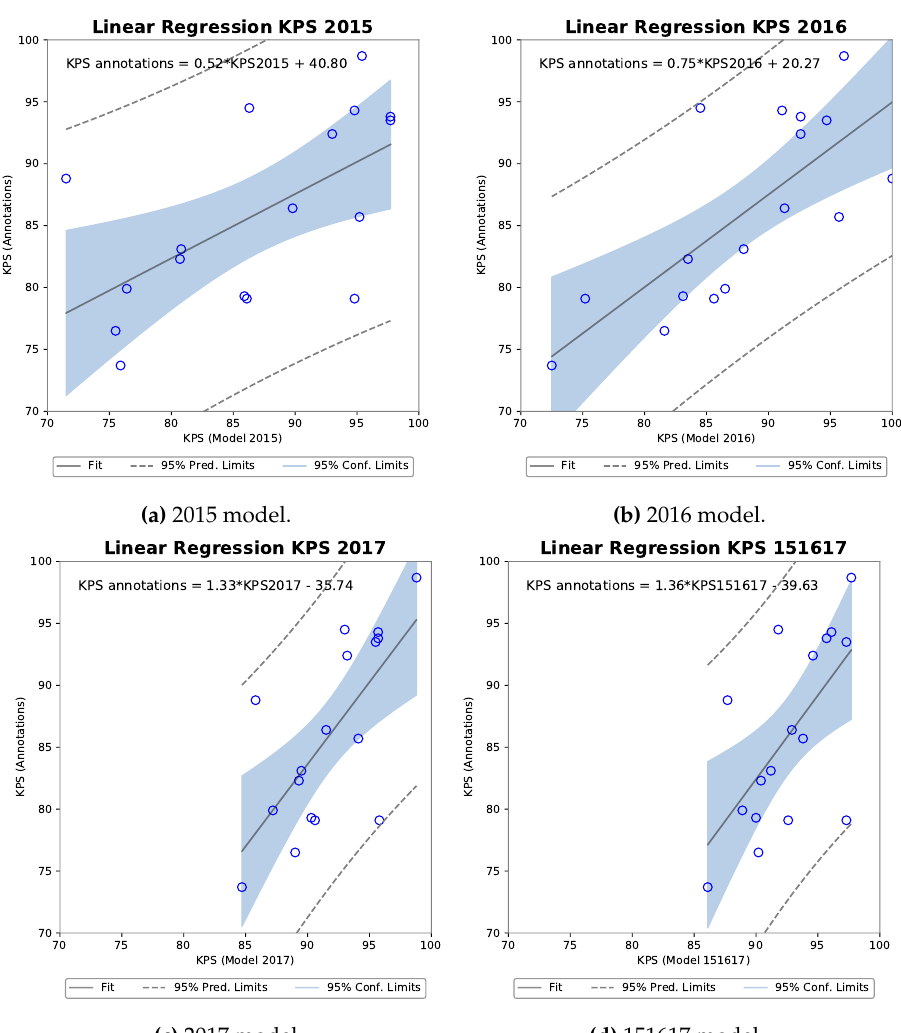
Figure 11. Four scatter plots of the MNC model KPS against annotation KPS with linear regression analysis computer for each.